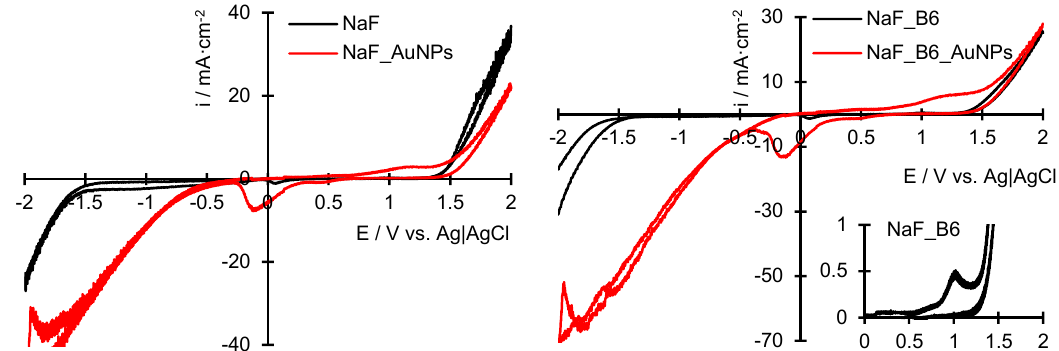
Figure 1. Cyclic voltammetry responses of gold electrode in 0.1 mol × L − 1 NaF support electrolyte in the absence and in the presence of 75 mg × L − 1 gold nanoparticles (AuNPs) and 2.9 × 10 − 4 mol · L − 1 pyridoxine (vitamin B 6 ).